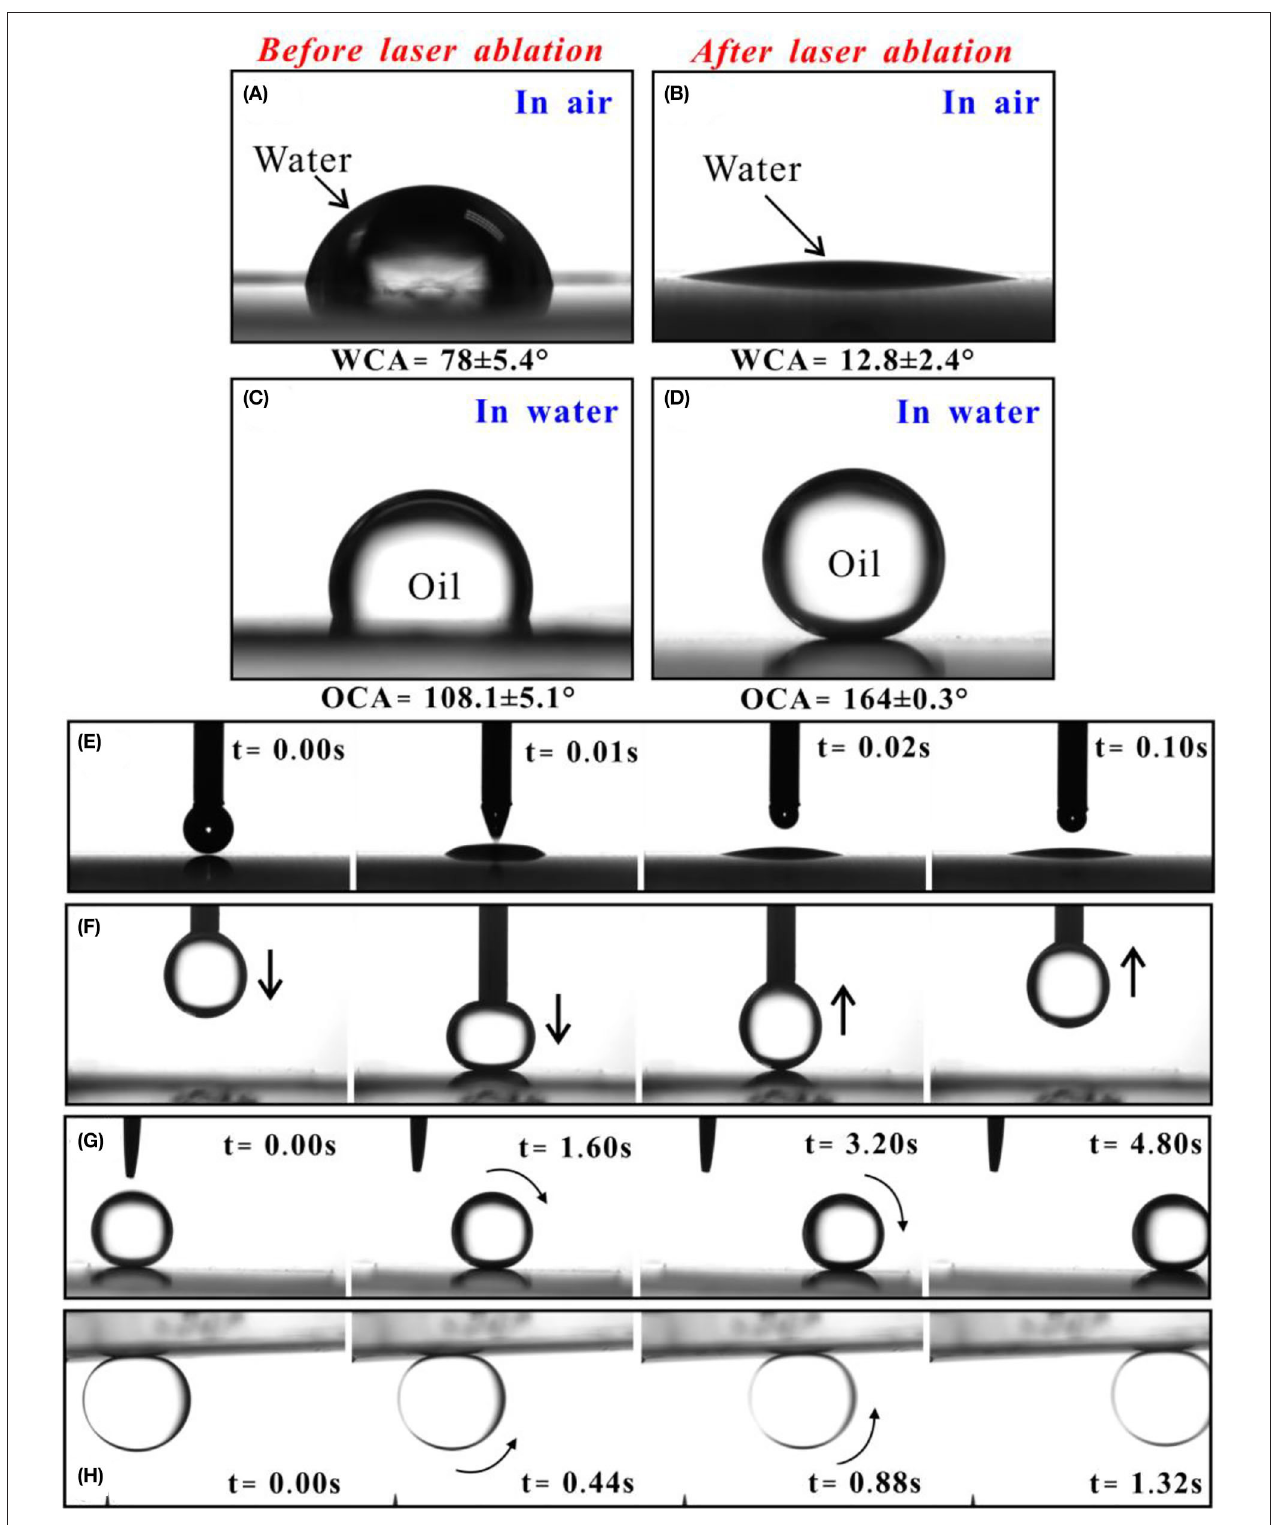
FIGURE 2 | Wettability of liquid droplet on the iron surface. (A) Water droplet on the untreated surfaces in air. (B) Water droplet on the laser-ablated surfaces in air. (C) Oil droplet on the untreated surfaces in water. (D) Oil droplet on the laser-ablated surfaces in water. (E) Dripping a small water droplet onto the laser-ablated surface in air. (F) Moving an underwater oil droplet to touch and then leave away the laser-structured surface. (G,H) Process of a droplet of (G) heavy oil and (H) light oil rolling on the laser-ablated surface in water.